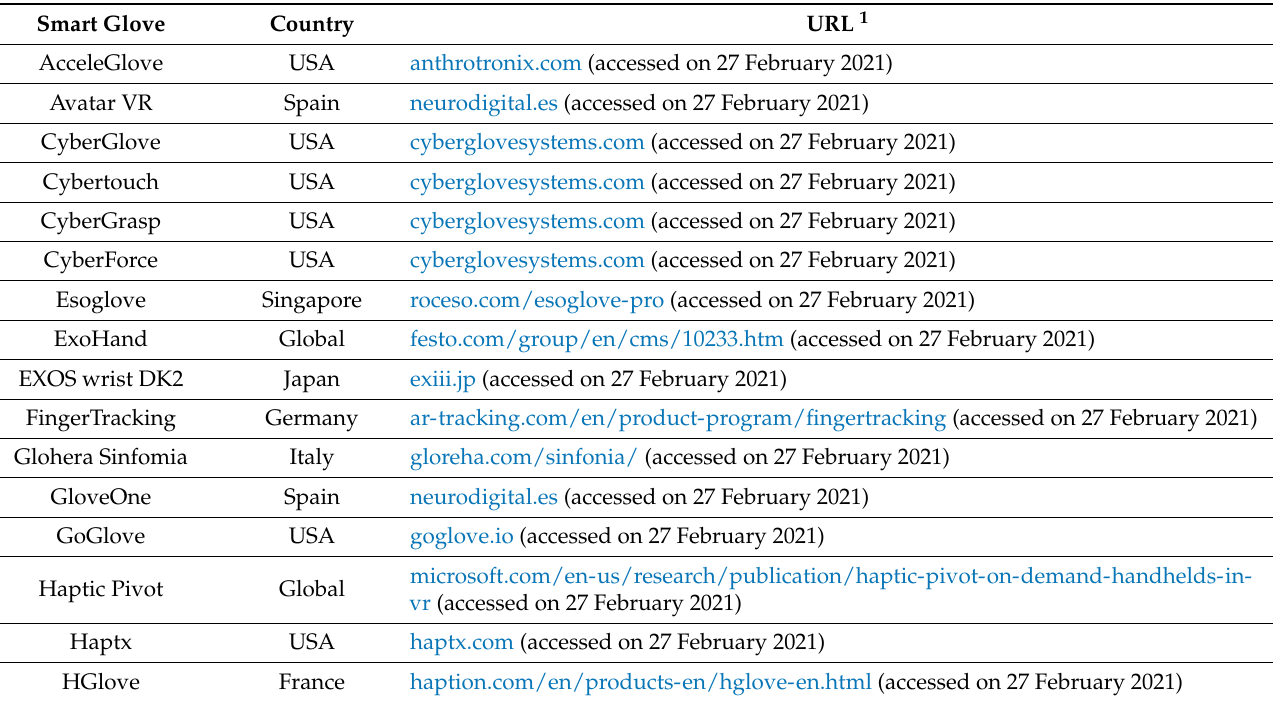
Table 1. Discarded